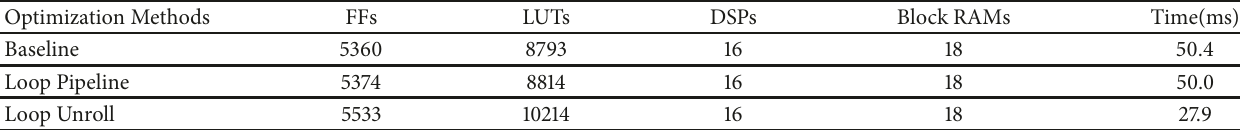
Table 5: The optimization results.